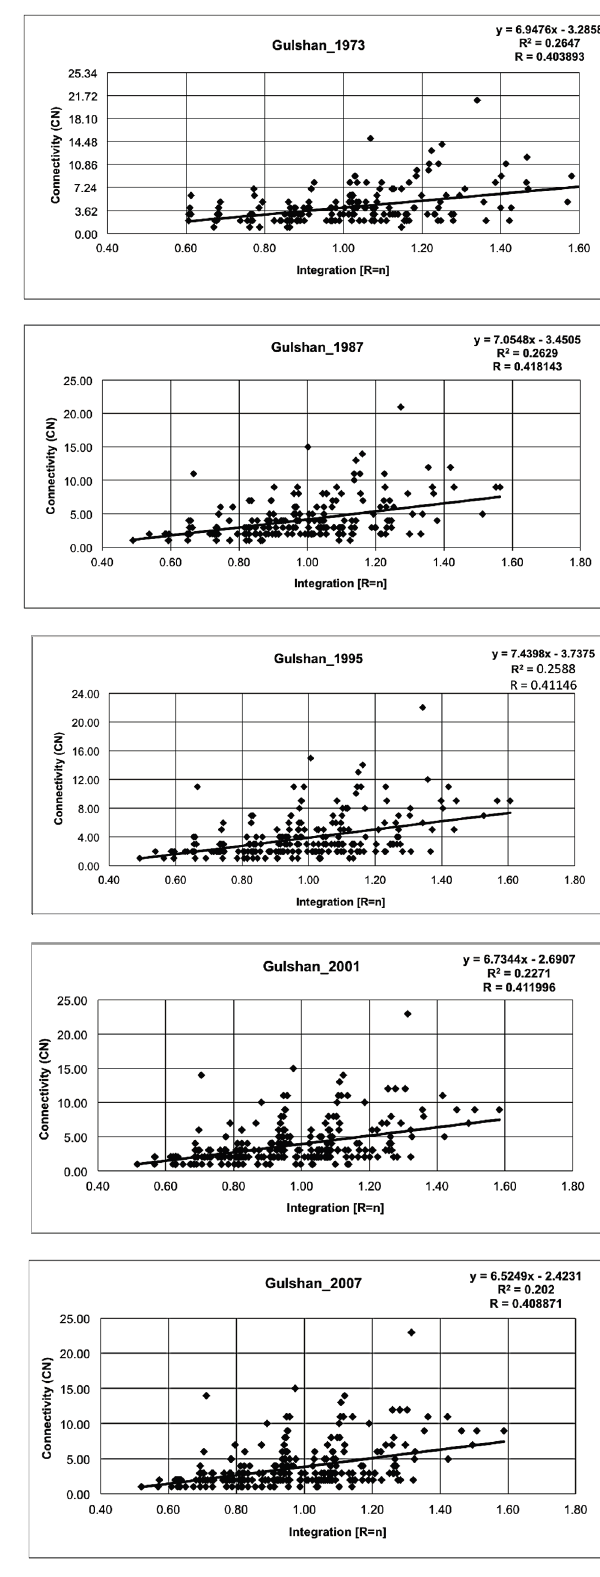
Figure 13. Scatter of correlation between local and global measures (R n -R3) and (R n -CN) of ward 19